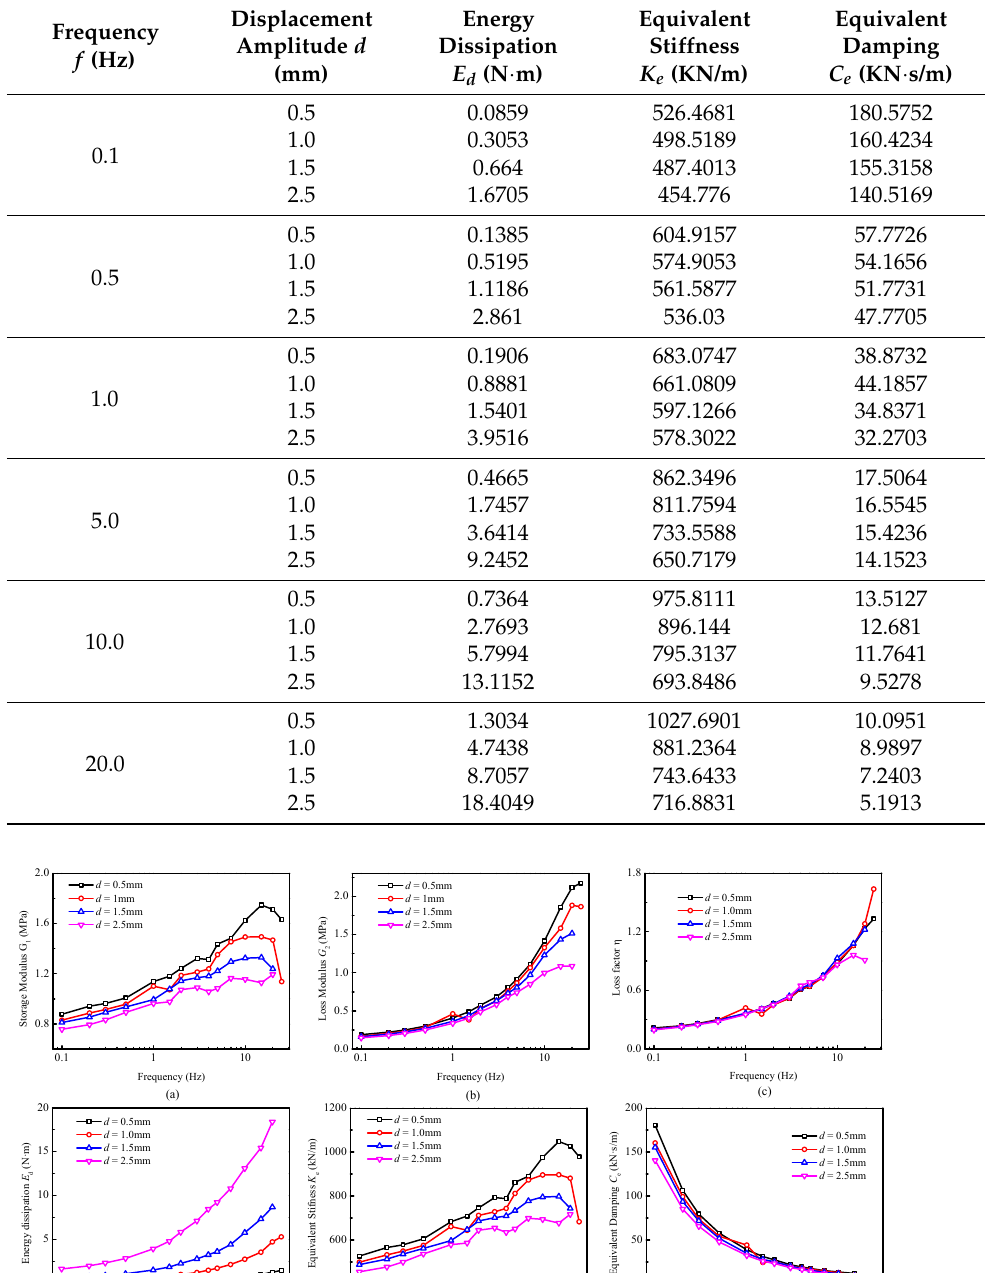
Table 3. Properties parameters E d , K e , and C e of the viscoelastic damper under different conditions.